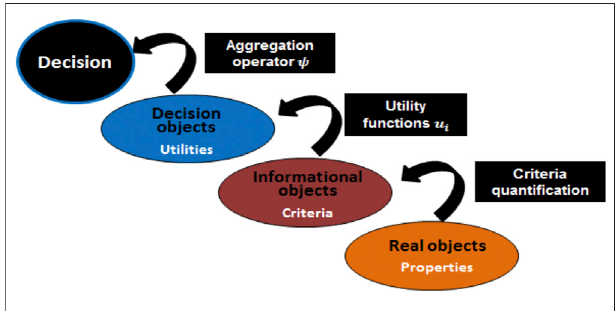
FIGURE 5 | Information transformation in the proposed